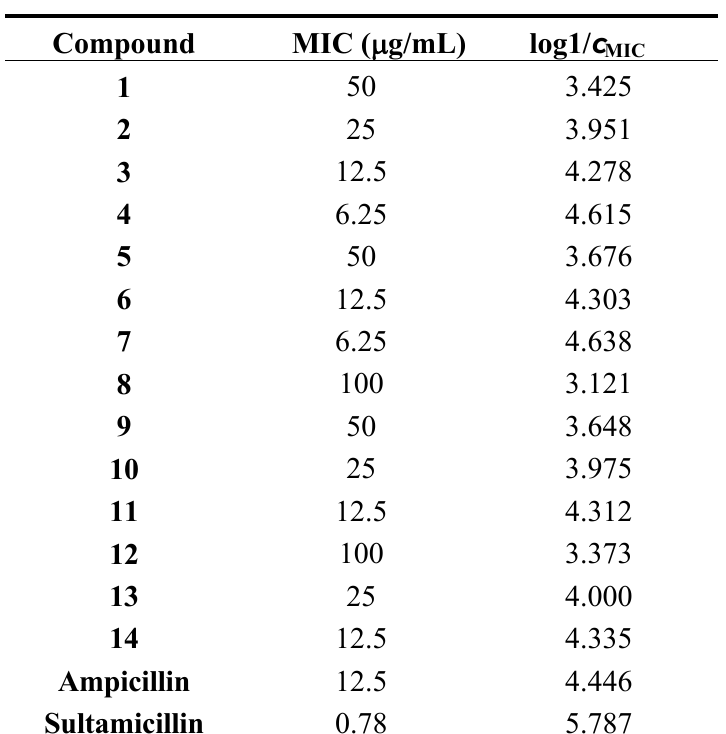
Table 2. Antibacterial screening